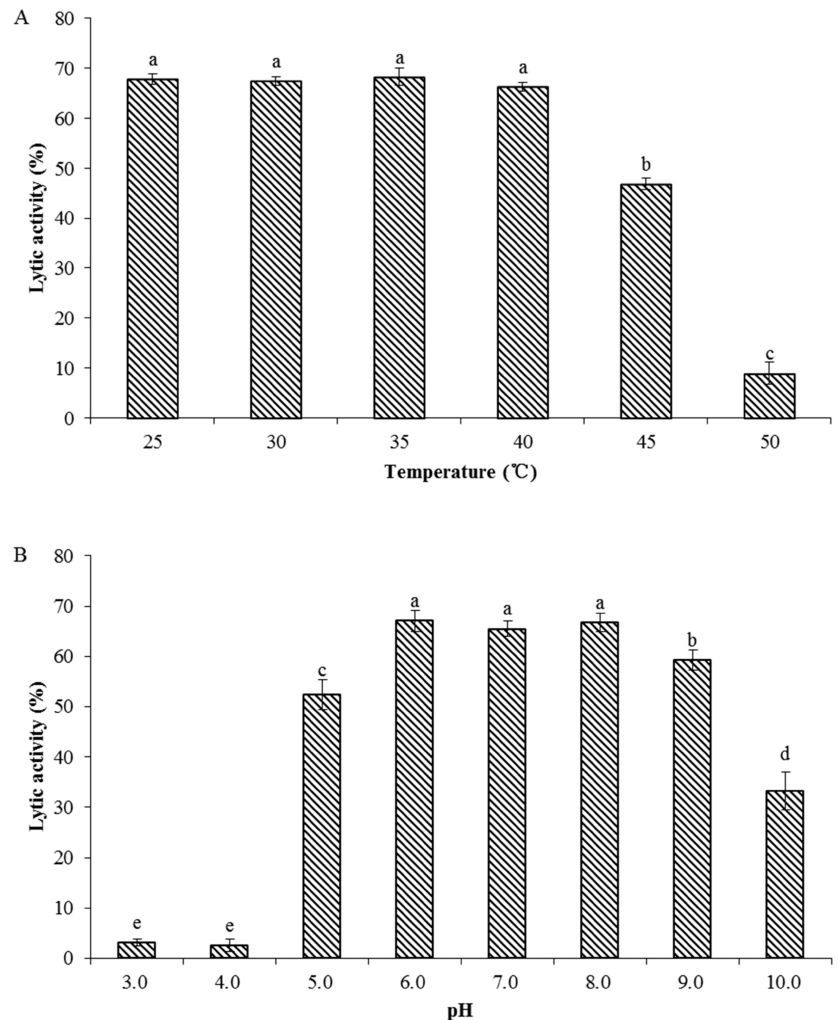
Figure 7. Stability of LysPN09. ( A ) Thermostability of the phage PN09 endolysin. LysPN09 (final concentration: 400.0 µ g/mL) was incubated at different temperatures for 30 min. ( B ) pH stability of PN09 endolysin. LysPN09 (final concentration: 400.0 µ g/mL) was incubated at the indicated pH conditions for 30 min. Shared letters above bars indicate no statistical difference among groups ( p > 0.05) and different letters above bars indicate a statistically significant difference ( p <